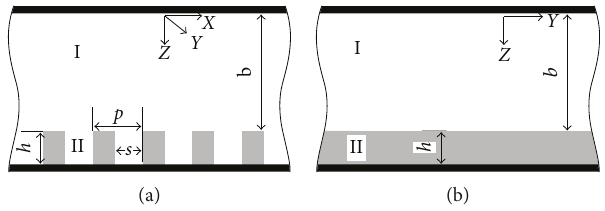
Figure 2: Diagram of unperturbed structure: (a) transverse section view and (b) longitudinal sectional